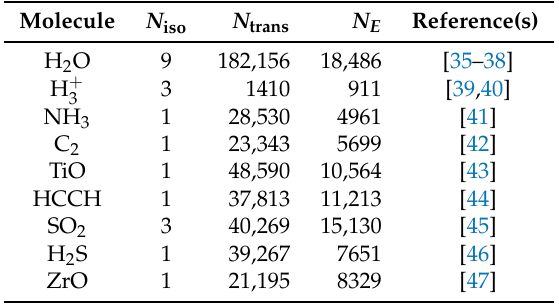
Table 1. Summary of MARVEL analyses performed for astronomically important molecules.